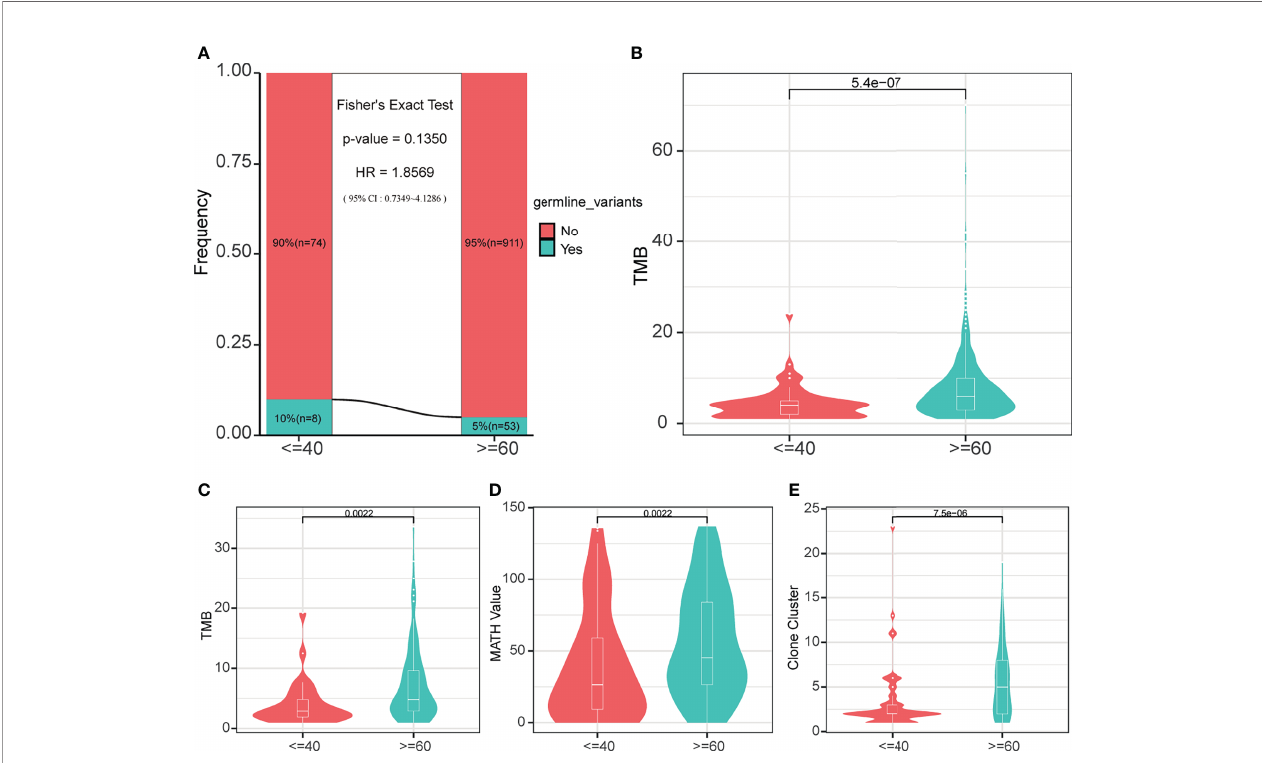
FIGURE 2 | Germline mutation status and somatic mutation characteristics. (A) Germline mutation frequency of two age-varying groups in the cohort with germline mutation information. (B) The TMB of patients in the cohort with germline mutation information. (C) The somatic TMB of patients in the 165-sample cohort. (D) MATH values of patients in the 165-sample cohort. (E) The number of clone clusters of patients in the 165-sample